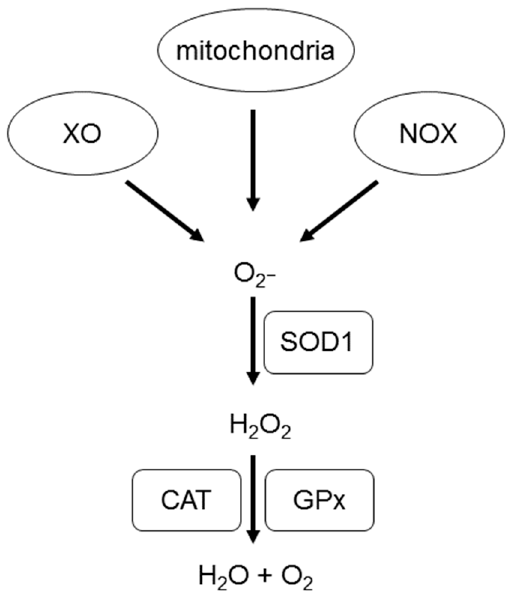
Figure 1. Generation of reactive oxygen species. Superoxide anion is produced by xanthine oxidase (XO), mitochondria, and NADP + oxidase (NOX). Superoxide anion is converted to hydrogen peroxide (H 2 O 2 ) by superoxide dismutase 1 (SOD1), and then to H 2 O and O 2 by catalase (CAT) and glutathione peroxidase (GPx).